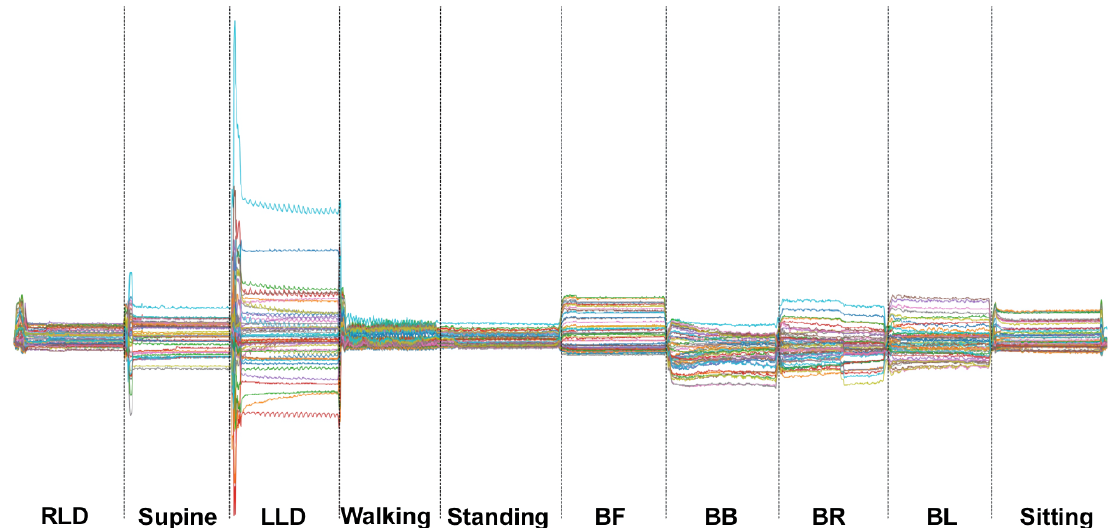
Figure 4. The recorded data for one of the subjects according to the protocol shows the indoor activities and data labeling based on